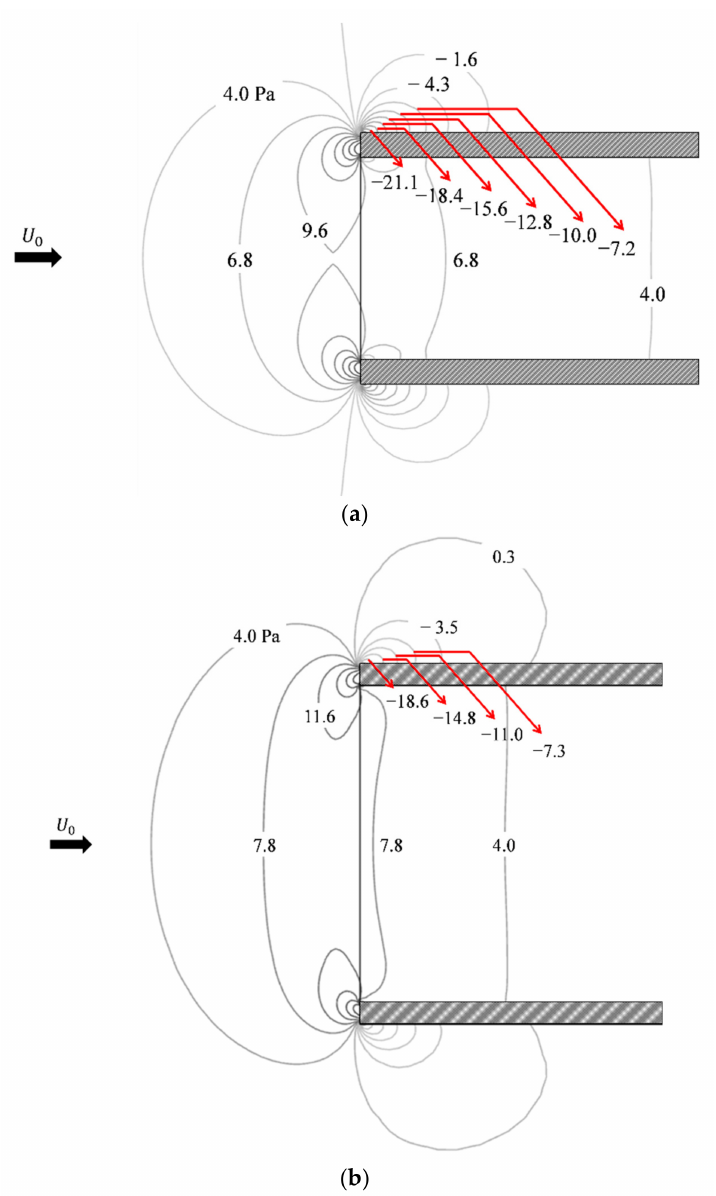
Figure 7. Pressure distribution of sampling probe at a free-stream velocity of 5 m/s: ( a ) circular inlet; and ( b ) ellipsoidal